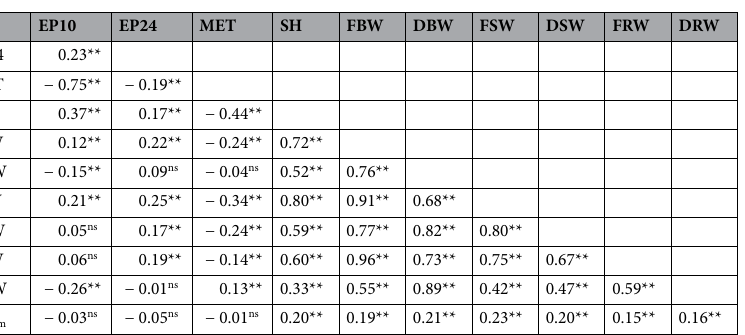
Table 8. Linear relationship based on correlation coefficient between investigated parameters. EP10 emergence percentage at 10th DAS, EP24 emergence percentage at 24th DAS, MET mean emergence time, SH shoot height, FBW fresh biomass weight, DBW dry biomass weight, FSW fresh shoot weight, DSW dry shoot weight, FRW fresh root weight, DRW dry root weight. **Significant at 0.01 probability level, ns